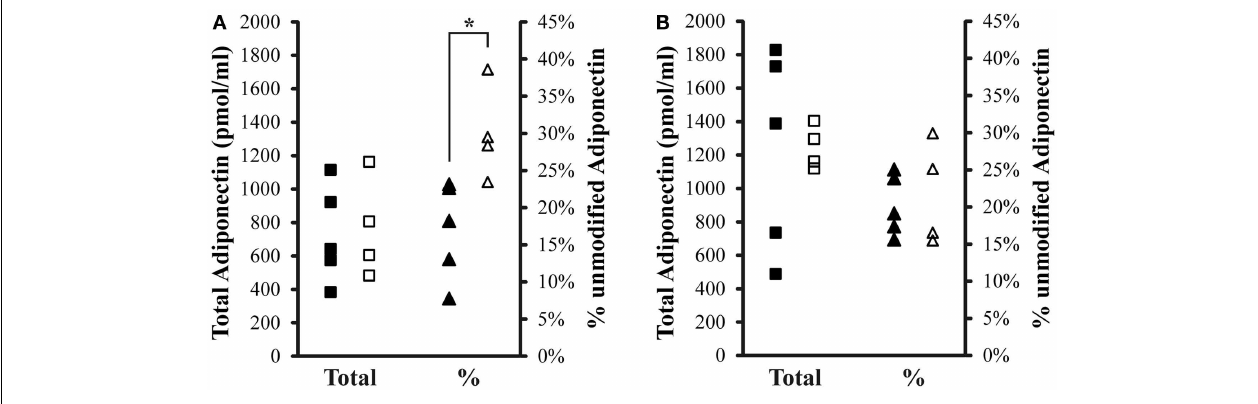
FIGURE 2 |Total and percent unmodified adiponectin levels in post-prandial and fasting samples . (A) Two hours post-prandial and (B) fasting sample sets. Squares are total adiponectin and triangles are